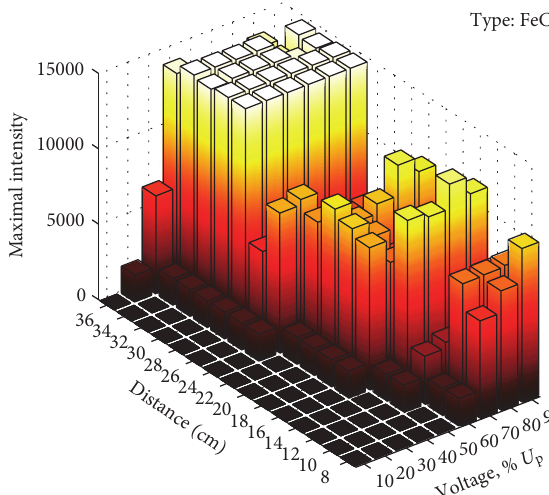
Figure 17: Dependency of voltage and distance on the highest intensity value for the FeCu line.